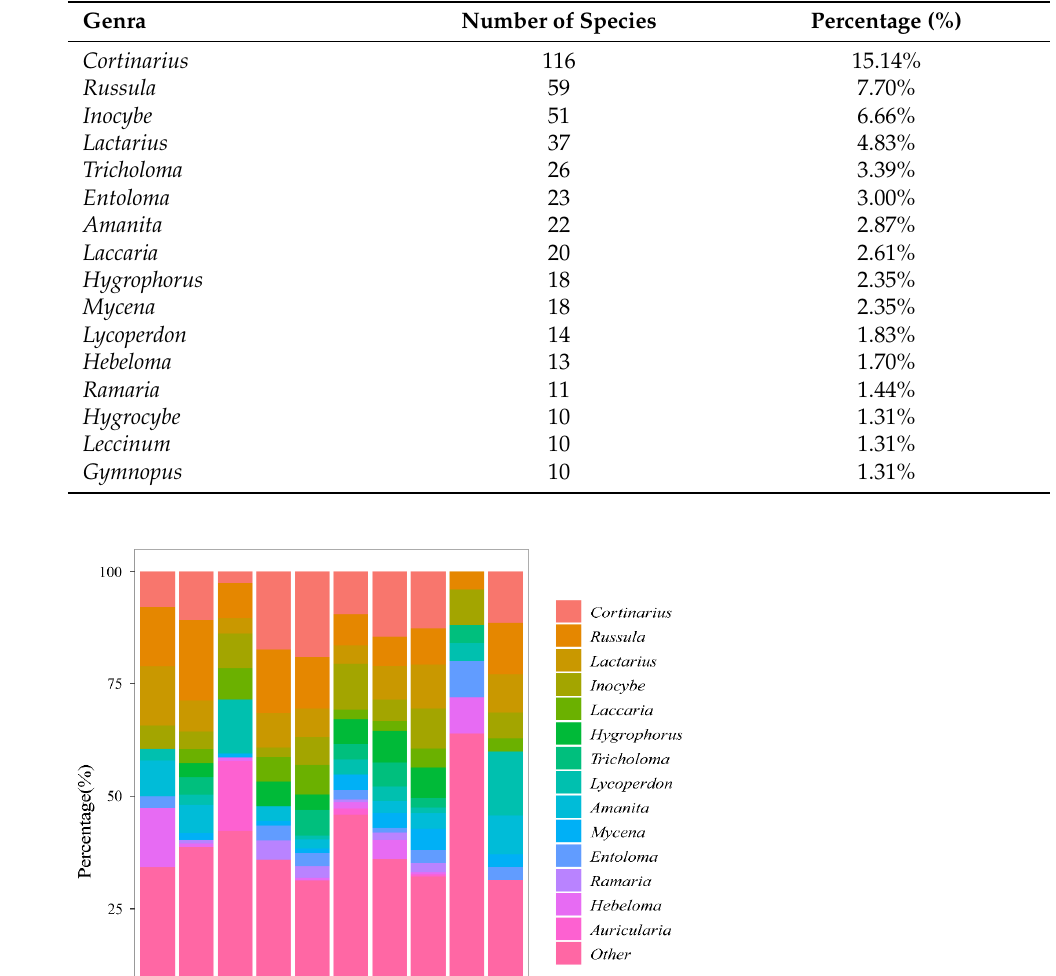
Table 3. Dominant genera ( ≥ 10 species) of macrofungi in Shaluli Mountains.